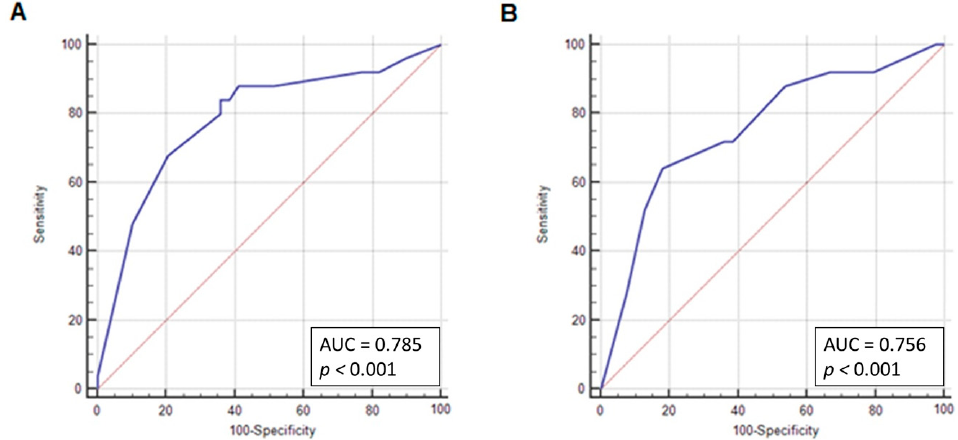
Figure 2. ROC curves for determining CD133 expression cut-off value in grading and FIGO staging. ( A ) ROC curve for determining CD133 nuclear localization cut-off value in grade 3. Cut-off point > 50%, p < 0.001, AUC = 0.79, sensitivity = 84%, and specificity = 64.1%. ( B ) ROC curve for determin- ing the localization of CD133 in the plasma membrane cut-off value in grade 3. Cut-off point ≤ 10%, p < 0.001, AUC = 0.76, sensitivity = 64%, specificity = 82.1%. 3.2. CD133 Expression in the Nucleus Is Positively Associated with Higher FIGO Stages IB-IV in Comparison to FIGO